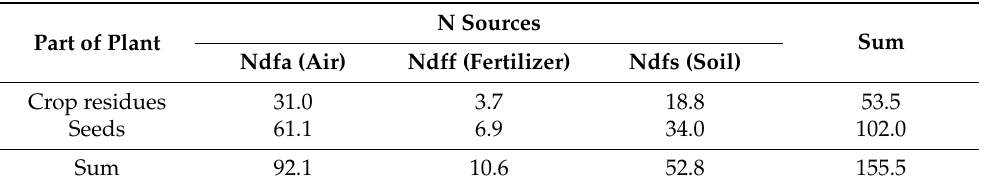
Table 10. The amount of nitrogen removed from the field with seeds and introduced into the soil with crop residues of peas at BBCH stage 90, kg N · ha − 1